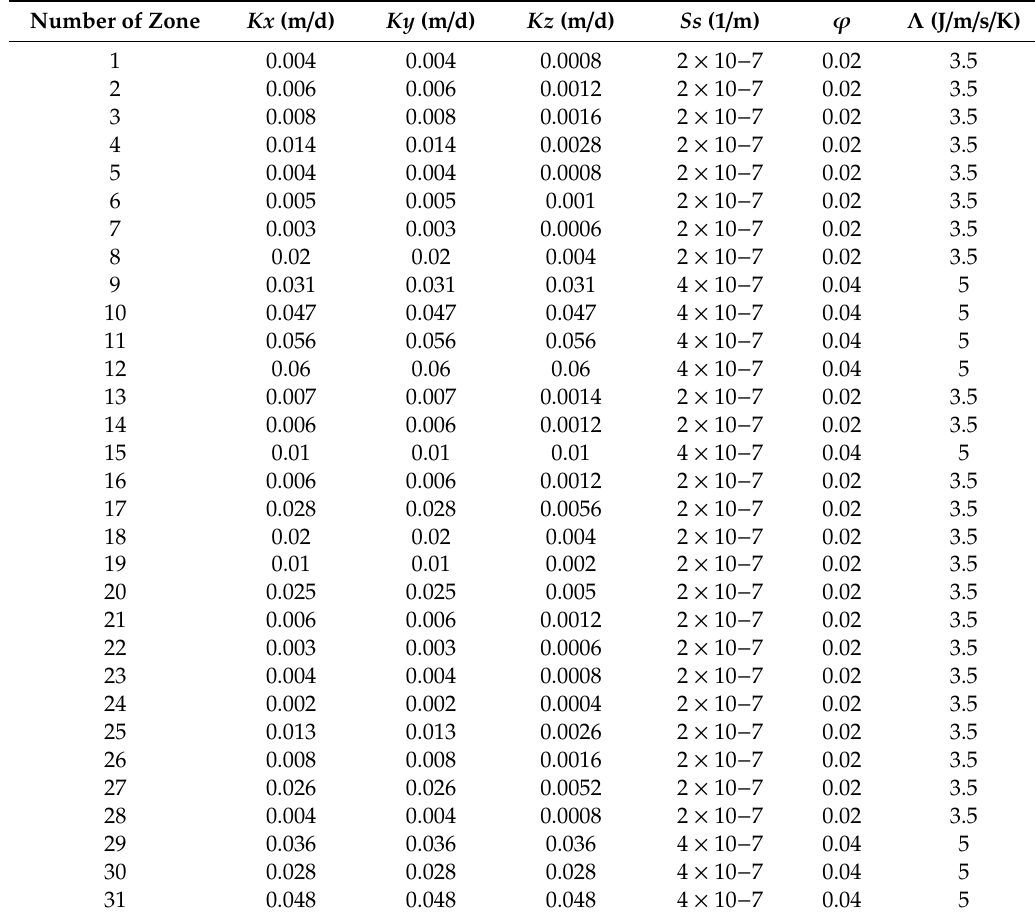
Table 5. Values of parameters used with the